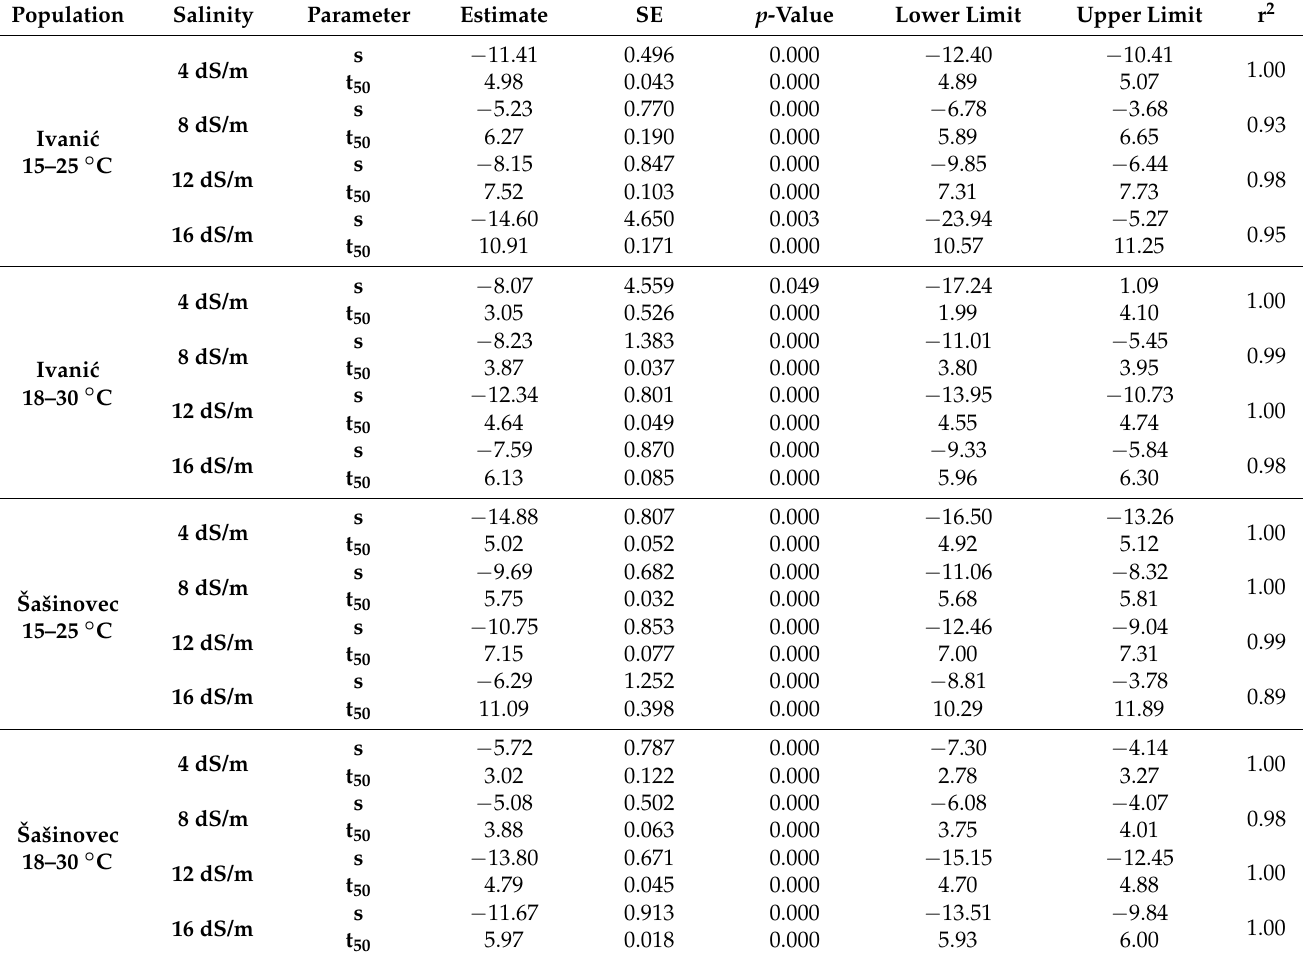
Table A1. Parameters of the log-logistic function for each population, temperature regime, and salinity level.